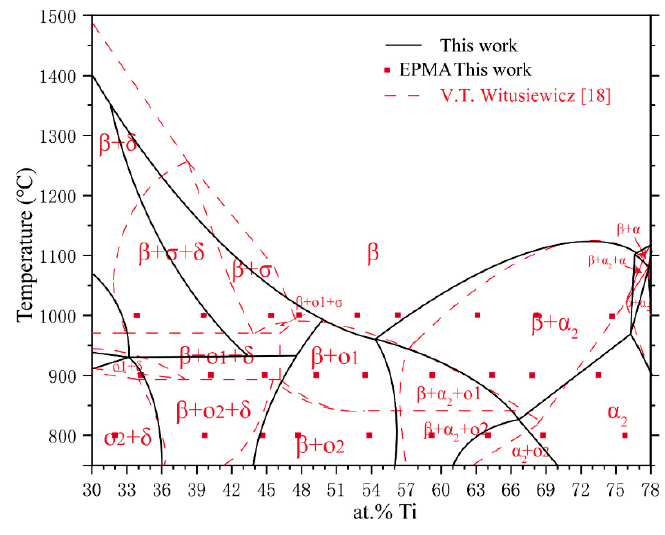
Figure 8. Experimentally determined the polythermal section of the Ti-Al-Nb ternary system compared with the result of Miracle et al. [20].